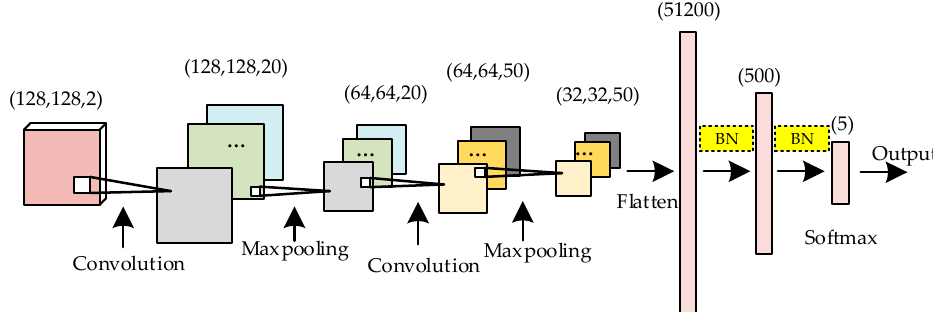
Figure 9. The structure of the ameliorated LeNet. LeNet: a network proposed by LeCun; Maxpooling: max pooling; BN: bath normalization.